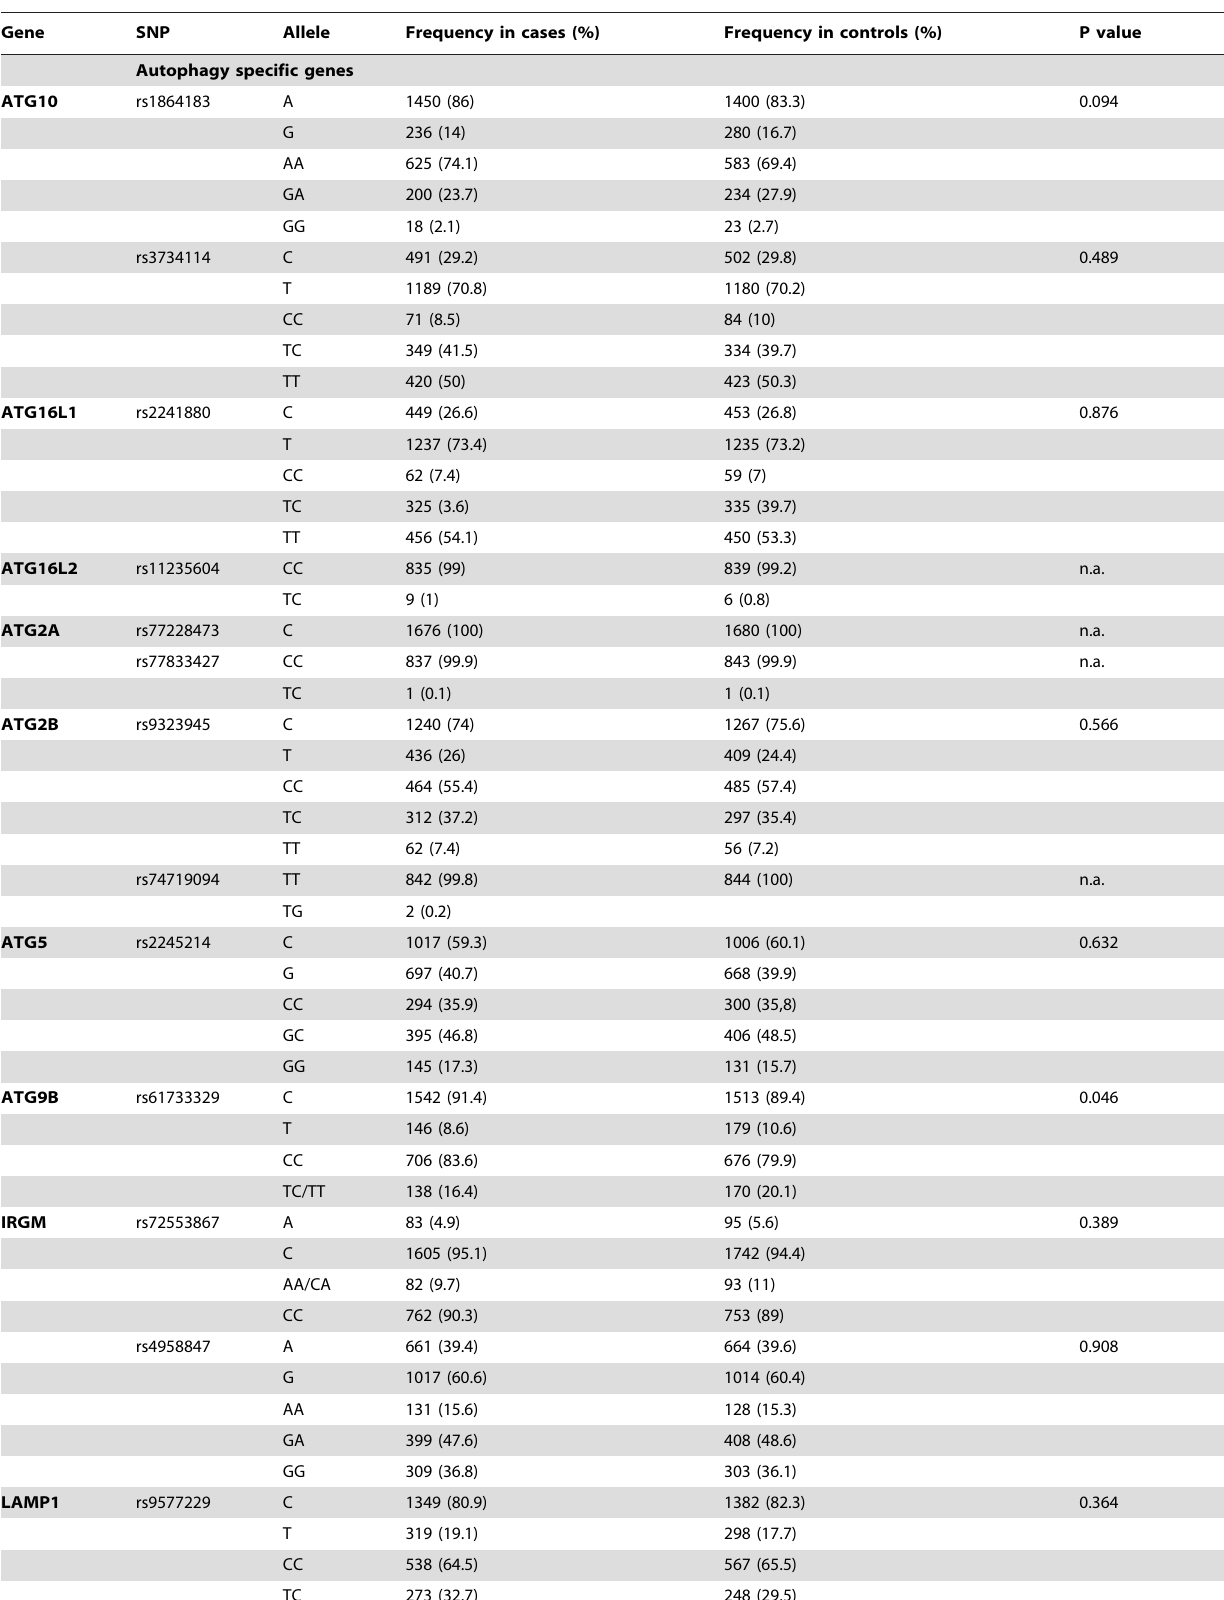
Table 3. Distribution of polymorphism allele frequencies in cases and controls.